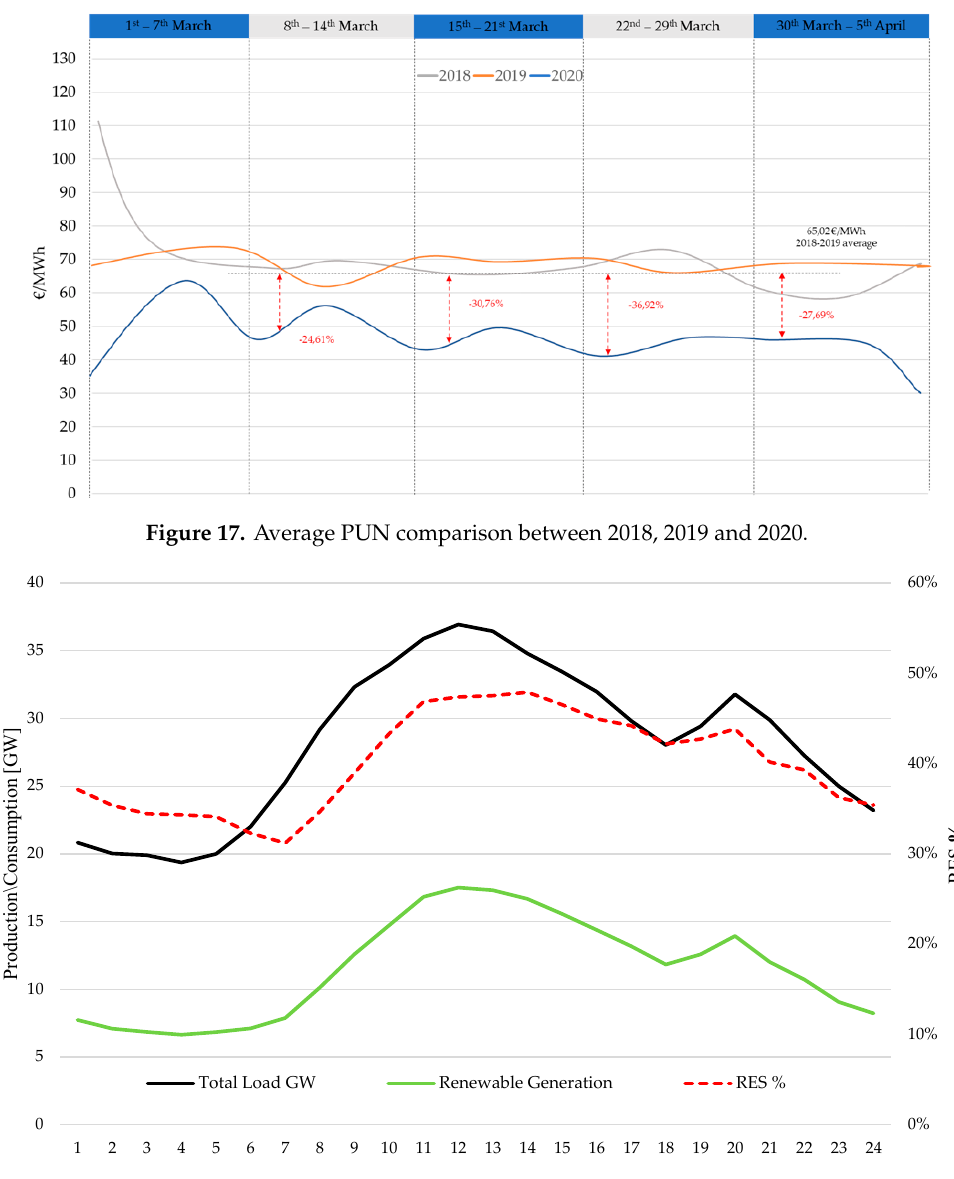
Figure 18. Low demand and high RES for the day of 23rd March 2020.